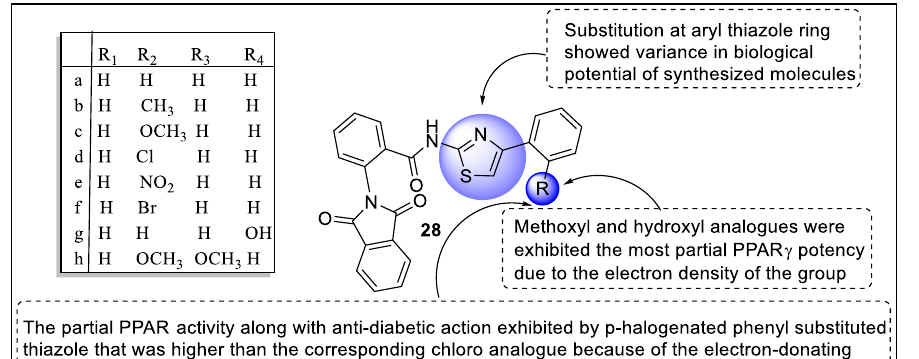
Figure 32. Structural activity relationship of Thiazole hybrids ( 28 ) as potent PPAR ligands.